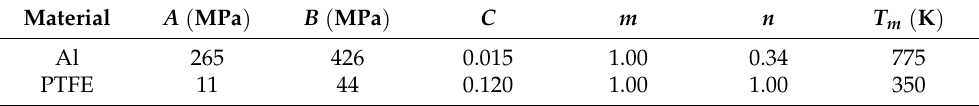
Table 2. Strength parameters of the materials.